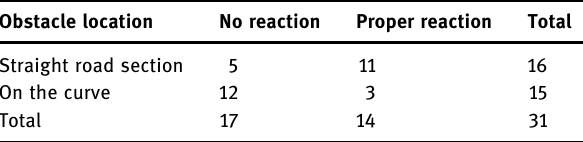
Table 4: System reaction depending on the obstacle location Obstacle location No reaction Proper reaction